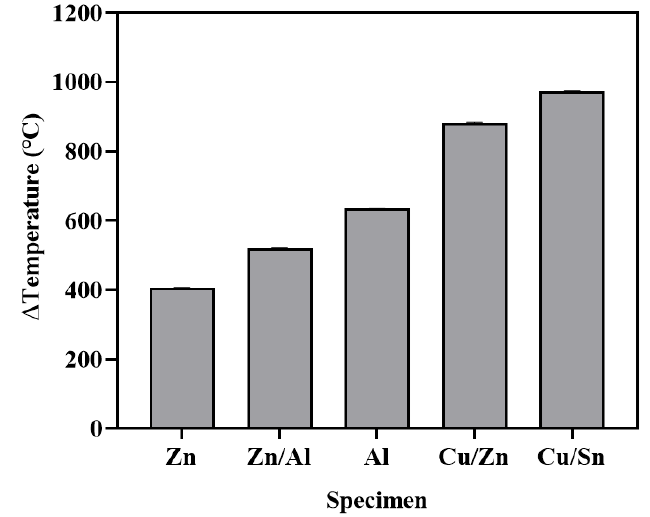
Figure 8. Difference between surface temperature and melting point.